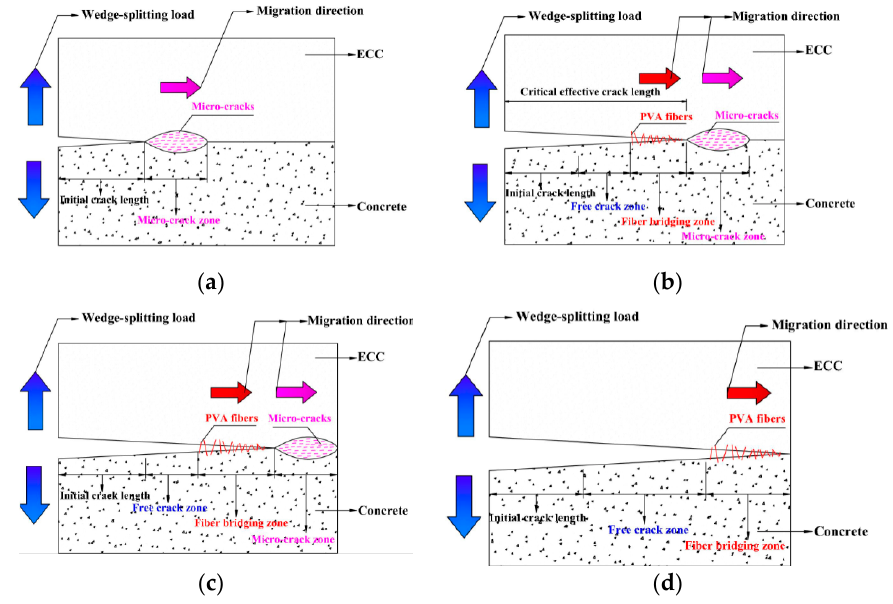
Figure 10. Fracture analysis with four phase (non-linear) [50]. ( a ) Initial crack, ( b ) stable crack propagation, ( c ) instability, and ( d ) instability.